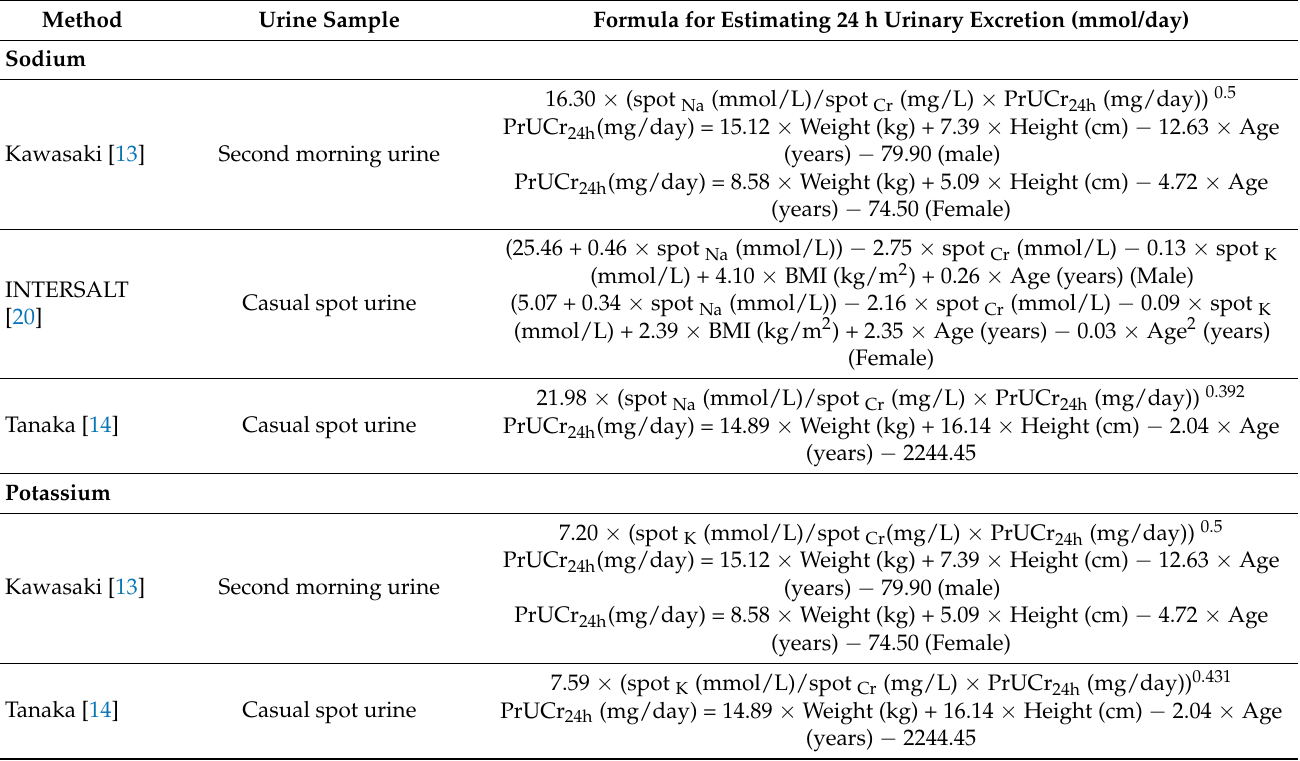
Table 3. The published formulas for estimating 24UNaV and 24UKV from spot urine